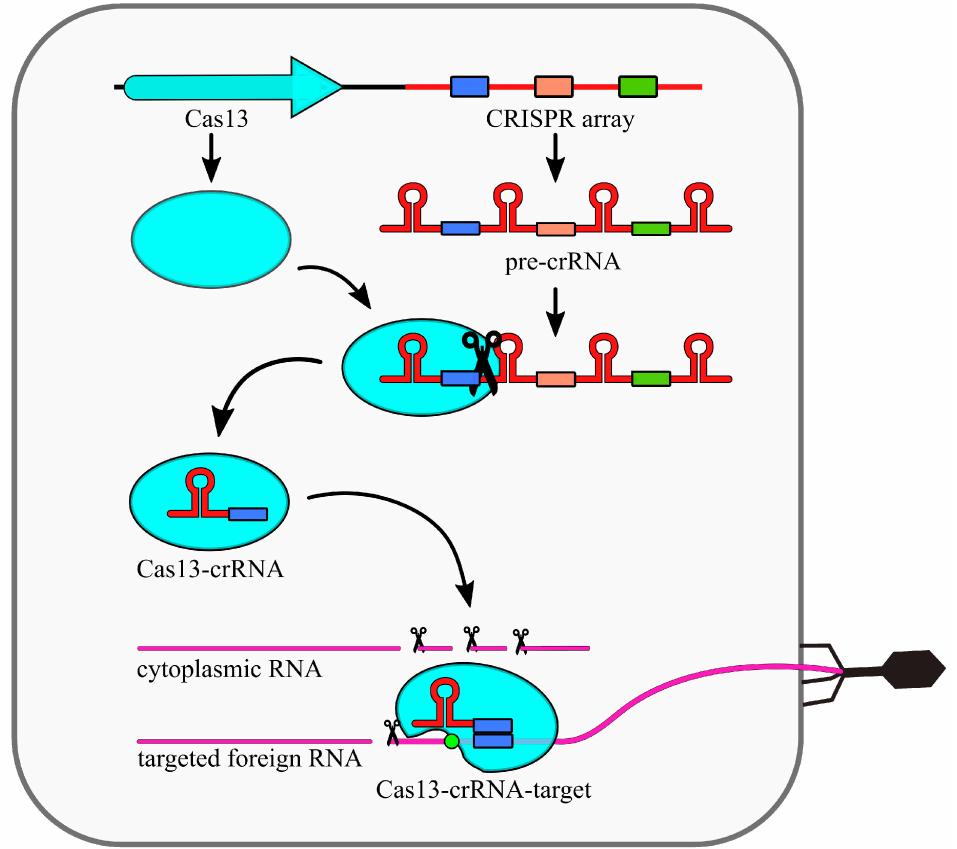
Figure 2. Mechanism of the CRISPR–Cas13 (type VI) system. The CRISPR array is transcribed into a long pre-crRNA transcript, which is subsequently processed into mature crRNAs by Cas13 protein. The crRNA-Cas13 complex scans the ssRNA searching for protospacer. Complementarity between crRNA and the protospacer sequence together with the presence of Protospacer Flanking Sequence (PFS) (green circle) induces conformational changes of Cas13, which results in higher eukaryotes and prokaryotes nucleotide binding (HEPN) domains activation and their displacement to the protein surface. This results in nonspecific RNA